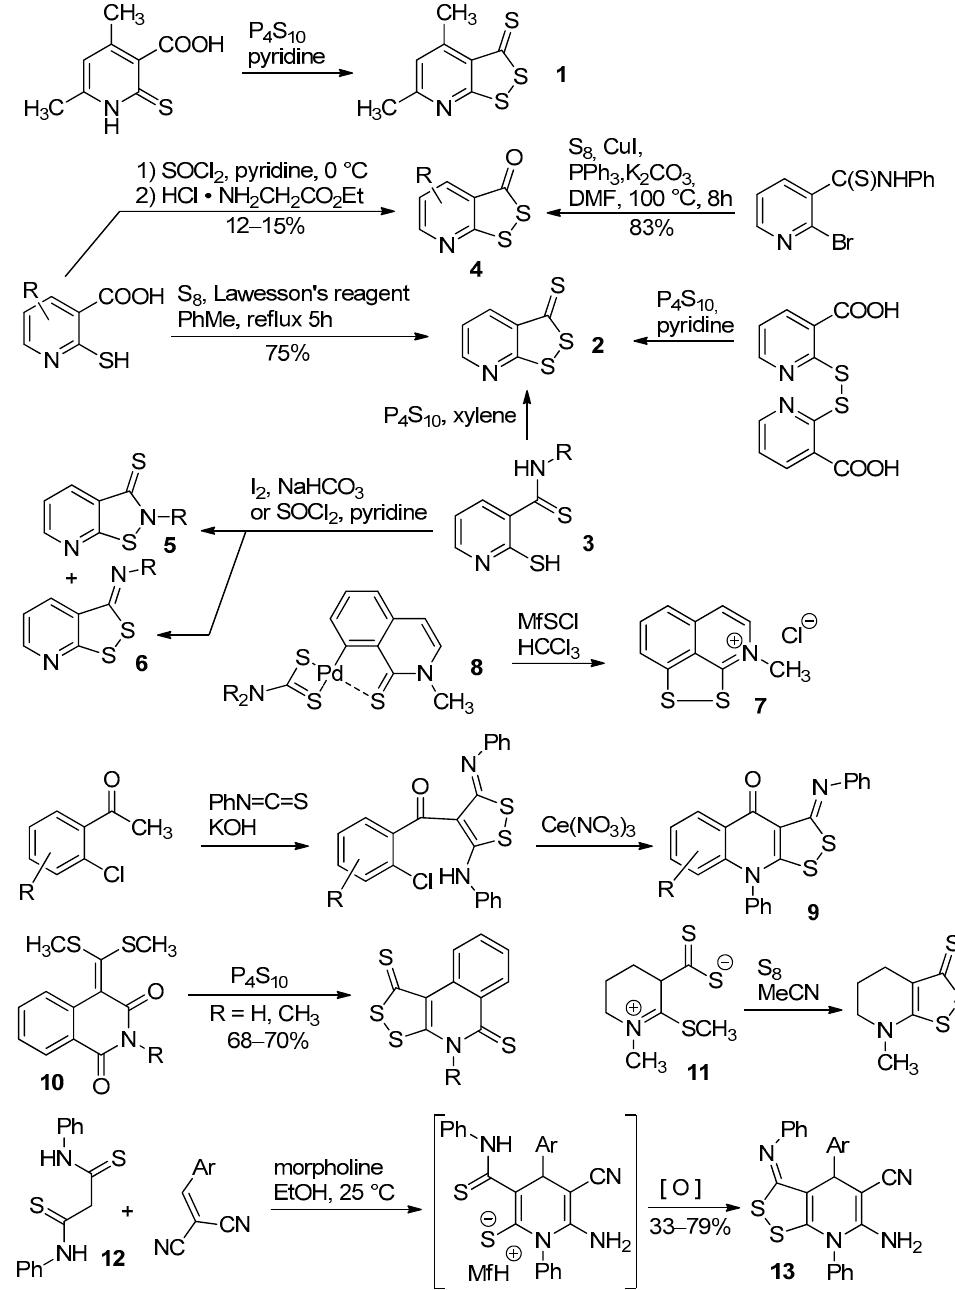
Molecules 2022 , 27 , x FOR PEER